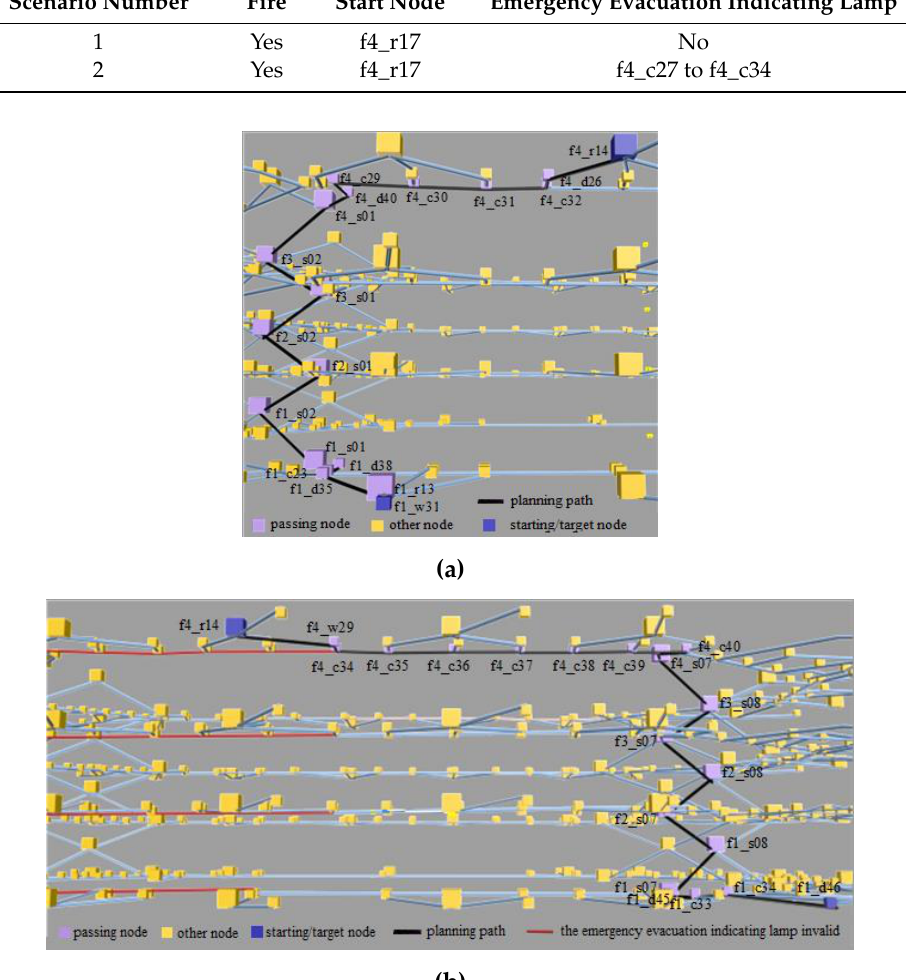
Figure 10. Impact of path recognition degree on indoor pathfinding. ( a ) Planning path in scenario 1; ( b ) Planning path in scenario 2. ( b ) Planning path in scenario